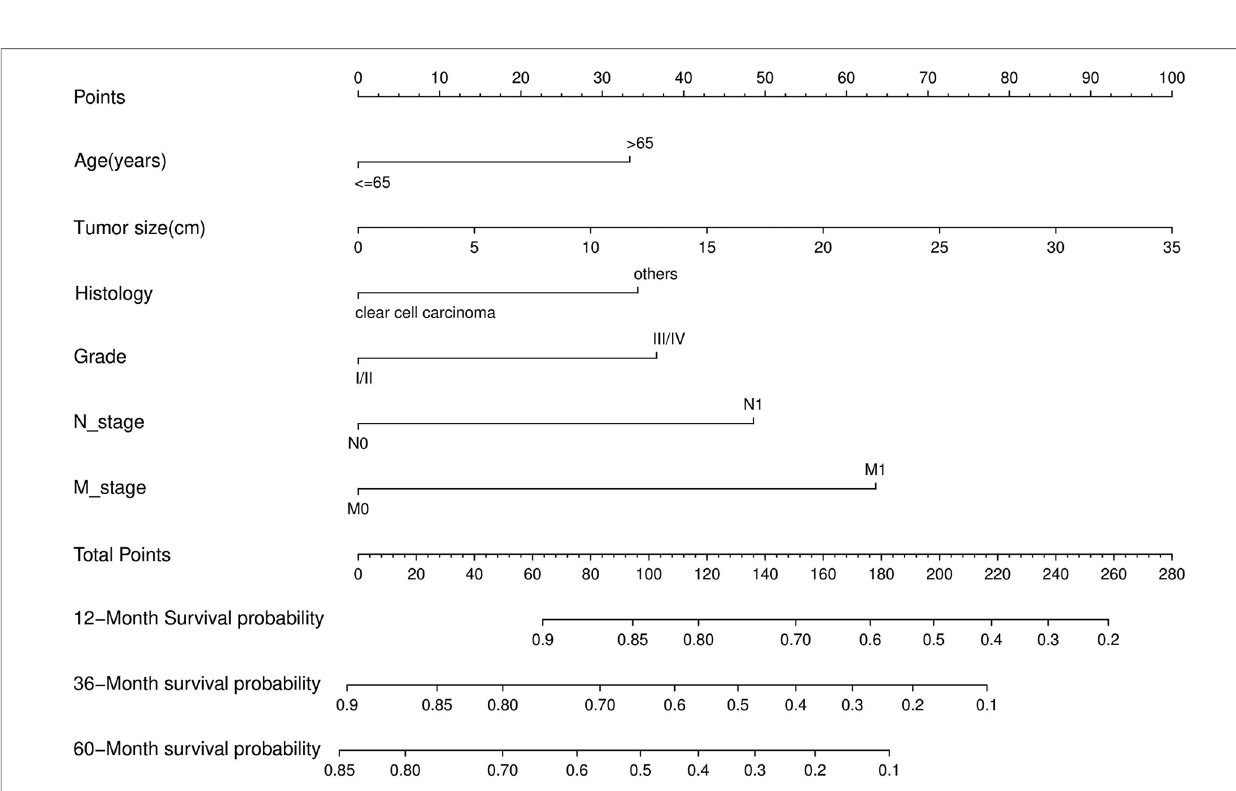
Frontiers in Surgery |